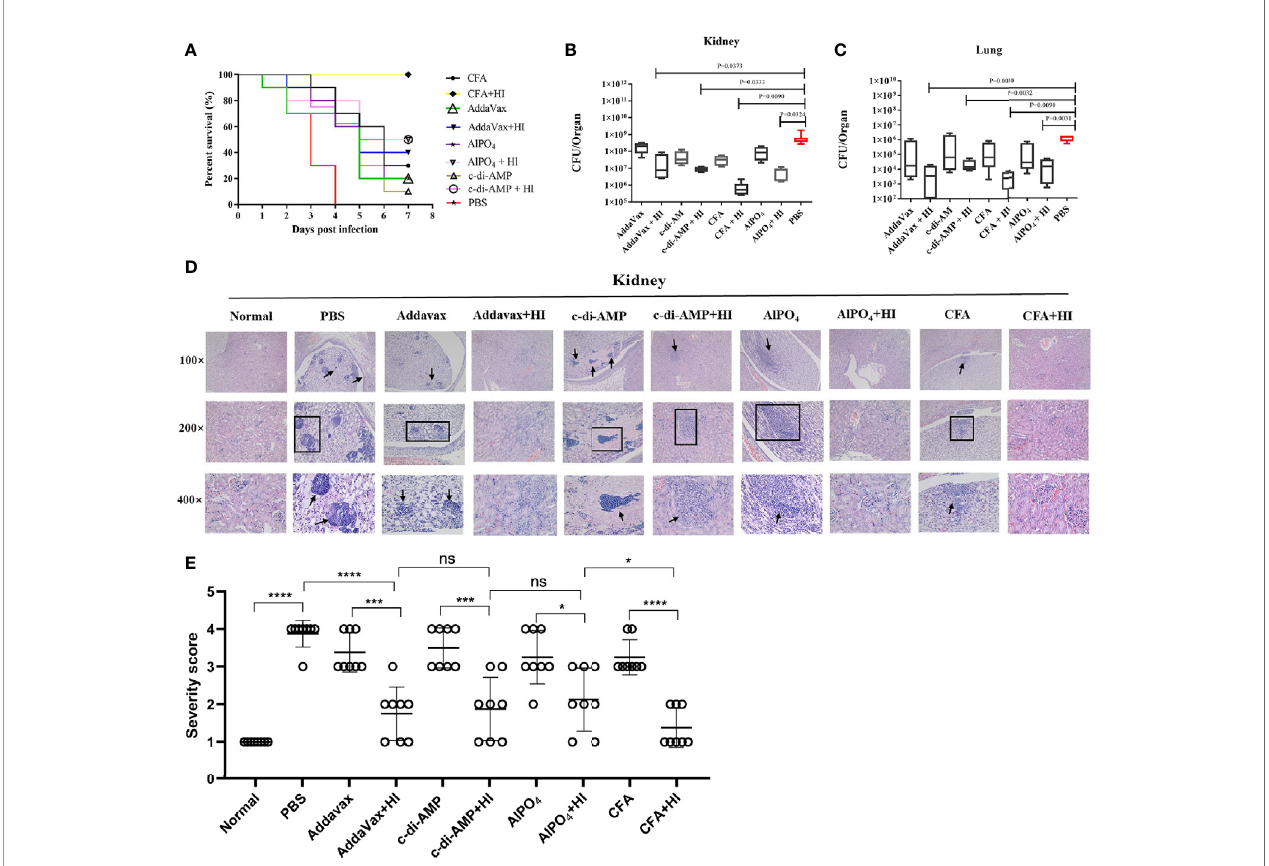
FIGURE 1 | The protective ef fi cacy of immunization with HI formulated with different adjuvants against MRSA252 challenge. (A) Percent survival in mice immunized with HI plus CFA, AlPO 4 , AddaVax or c-di-AMP adjuvant, adjuvant alone or PBS as a control (n =10). Bacterial burden in the kidneys (B) and lungs (C) of immunized mice after challenge with MRSA252 (n = 8). The difference in each group is indicated by the p value. (D) Histological analysis of immunized mice after challenge with MRSA252. Hematoxylin and eosin staining of kidney sections 48 h after MRSA252 infection, 100 × (top row), 200 × (middle row) and 400 × (bottom row). Abscess formation or scattered colonies of bacteria were found only in adjuvants alone or PBS-immunized animals (black arrow). (E) Severity scores of lungs (n = 8) from immunized mice and control mice are shown 2 days postinfection. Data are presented as scatter plots. ns, not signi fi cant; *p < 0.05, ***p < 0.001, ****p <